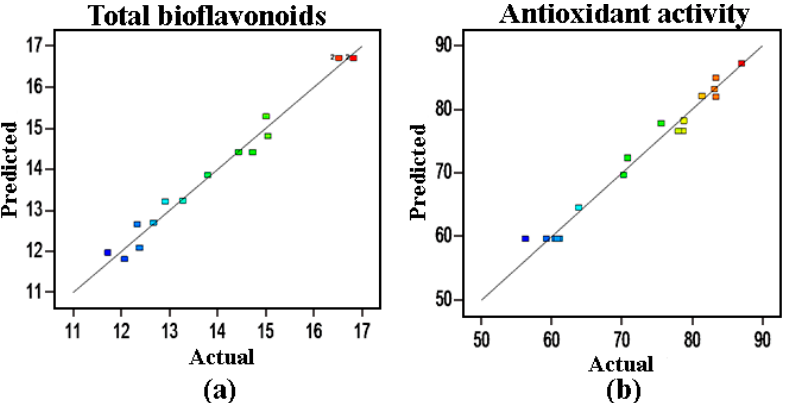
Figure 3. Correlation graph between the predicted and experimental yield values. ( a ) The correlation graph of total biflavonoids content, color points from red to blue indicate values of bioflavonoids changing in the scope of 11 ~ 17 mg/g; ( b ) The correlation graph of antioxidant activity, color points from red to blue indicate values of IC 50 changing in the scope of 50 ~ 90 μ g/mL.